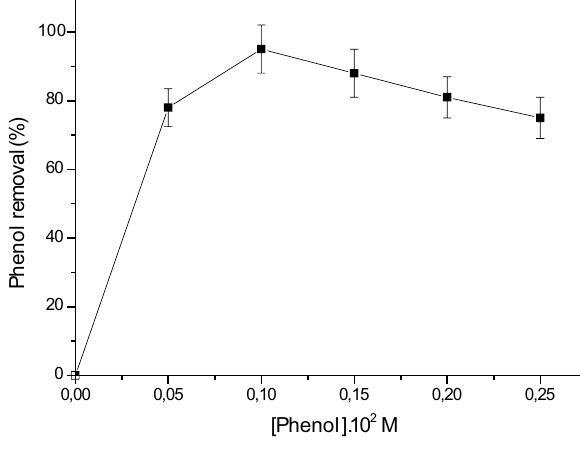
Fig. 3 Effect of stirring speed on removal of phenol. Transport con- ditions: feed phase: phenol 10 −3 M, pH 2. Stripping phase: NaOH 0.20 M. Membrane: 12.60 cm 2 of surface area, calix[4]resorcinarene: RC8 (0.15 g/g mixture of polymers), 0.03 ml 2-NPOE/g mixture of polymers values obtained after 6 days of transport